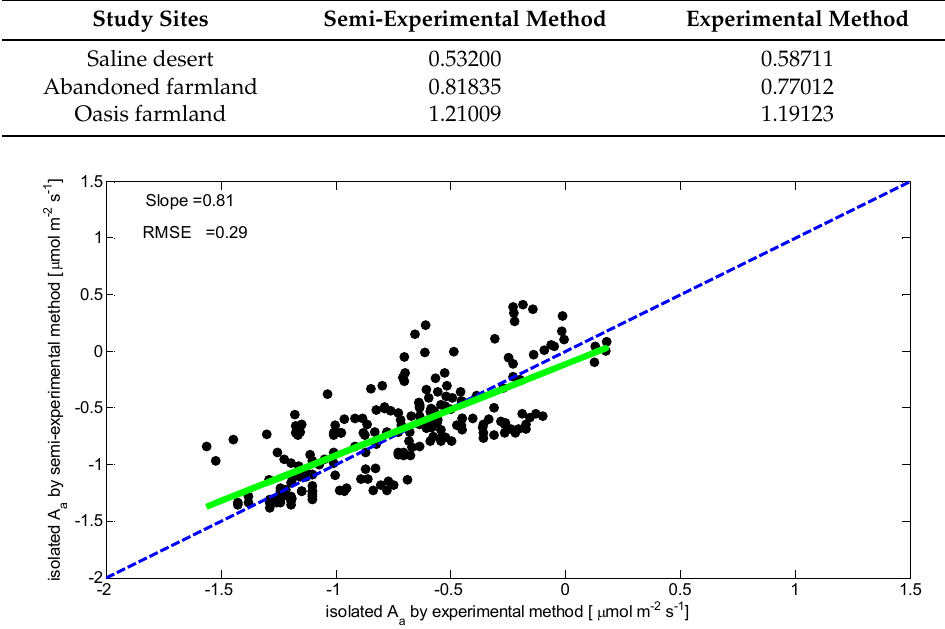
Figure 7. Reliability of semi ‐ experimental partition method (the green line is the linear regression line determined by the observed values and the simulated values) utilizing a linear regression curve (the green line). The diagonal blue line is taken as a reference.